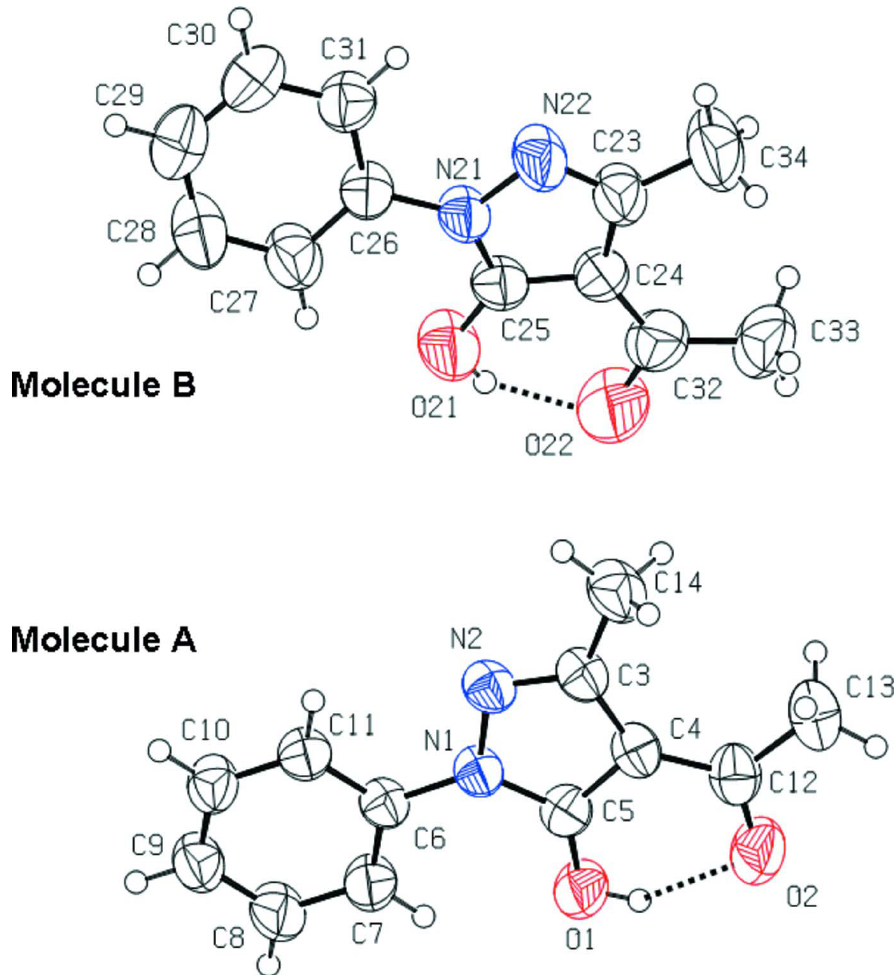
Figure 1 A view of the molecular structure of the two independent molecules (A and B), showing the displacement ellipsoids drawn at the 50% probability level and the intramolecular O—H···O hydrogen bonds as dashed lines. Hydrogen atoms are represented as spheres of arbitrary